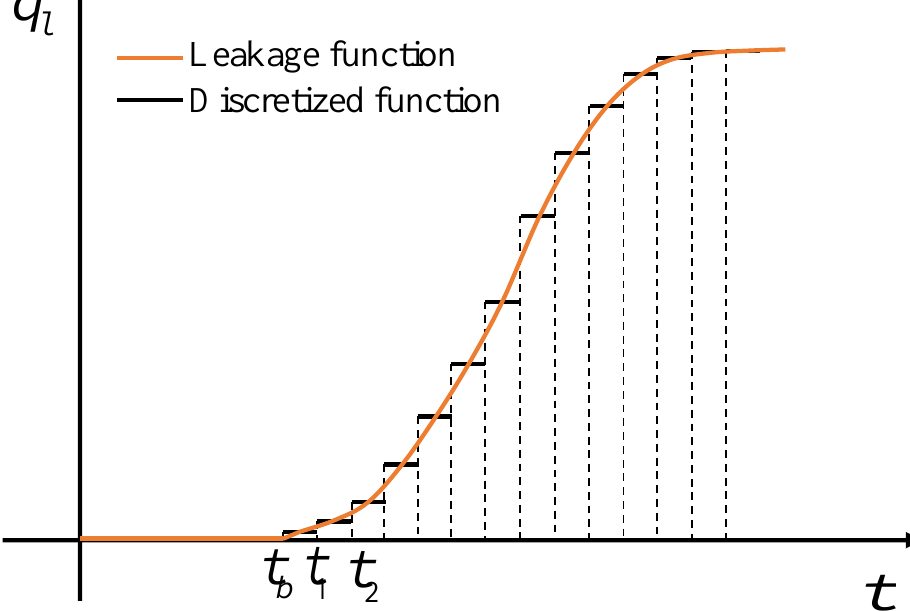
Figure 3. Discretization of a leakage rate function into a piecewise constant